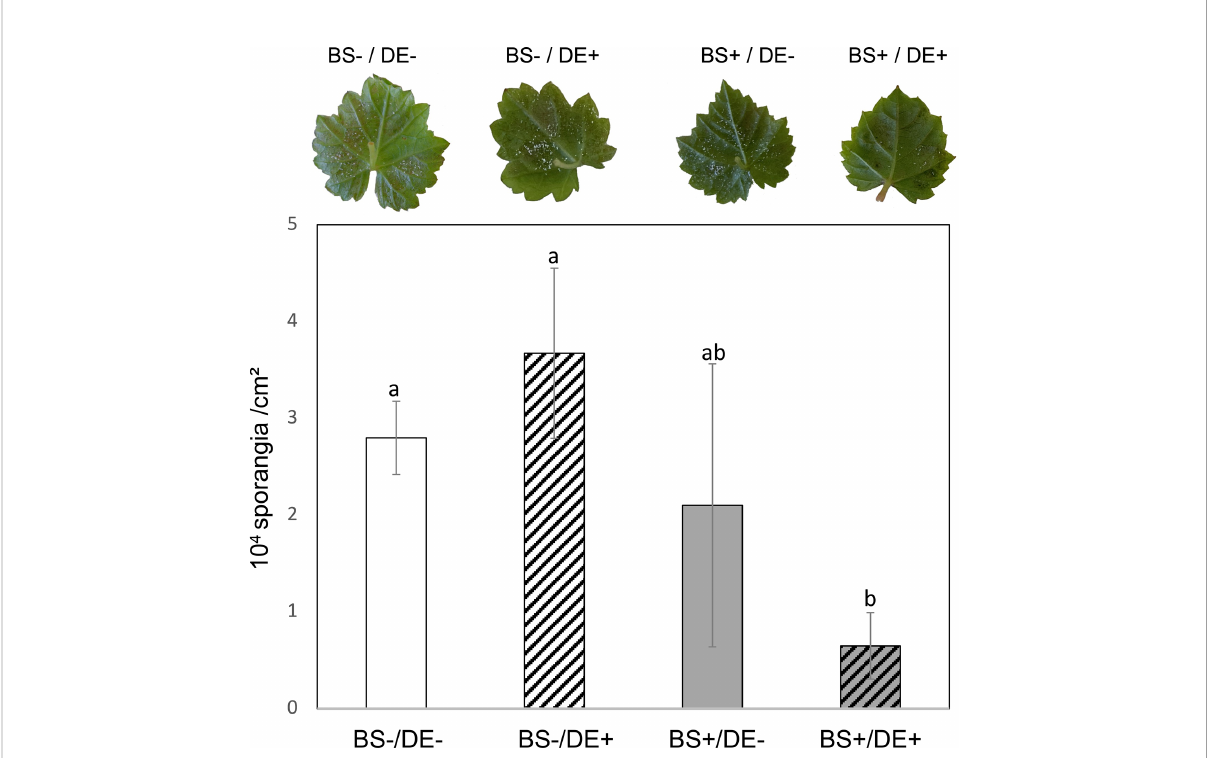
FIGURE 10 Evaluation of Plasmopara viticola sporulation according to the different treatments. Grapevine micro-cuttings were transplanted in a solid medium supplemented with BS 0.1% (v/v, “ BS+ ” ) or water ( “ BS- ” , as control). At 4 wpt, they were divided into two sets: one treated by immersion in a defense elicitor solution (DE+) and the other one in water as control (DE-). Two days later, leaves were detached and inoculated with a P. viticola sporangia suspension. Sporulation was evaluated at 7 days post inoculation. Top: Photographs representative of the pathogen sporulation observed on the lower surface of the leaves. Bottom: histogram showing the evaluation of the density of sporangia per leaf area (cm 2 ). The bars represent the standard deviations and a signi fi cant difference is observed when the treatments have no letter (a or b) in common ( P <0.05; Kruskall-Wallis